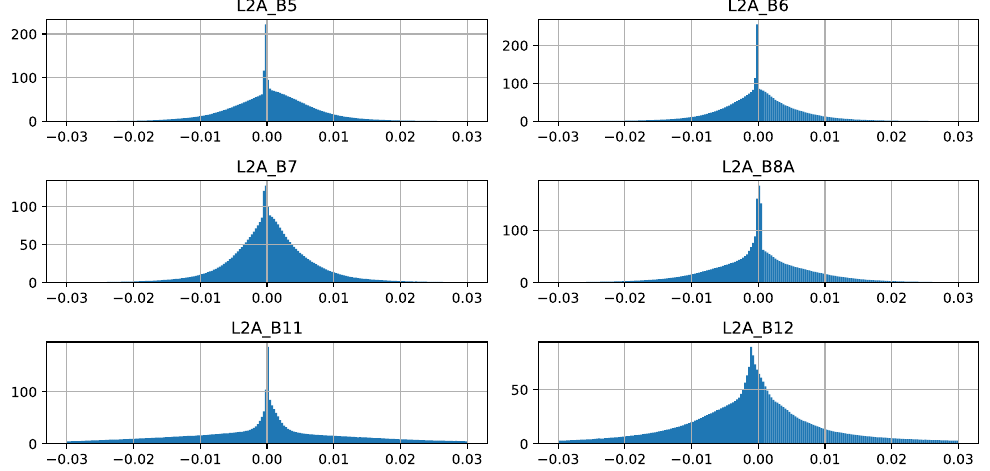
Figure 10. Histograms of the errors (true value minus prediction) for the L2A